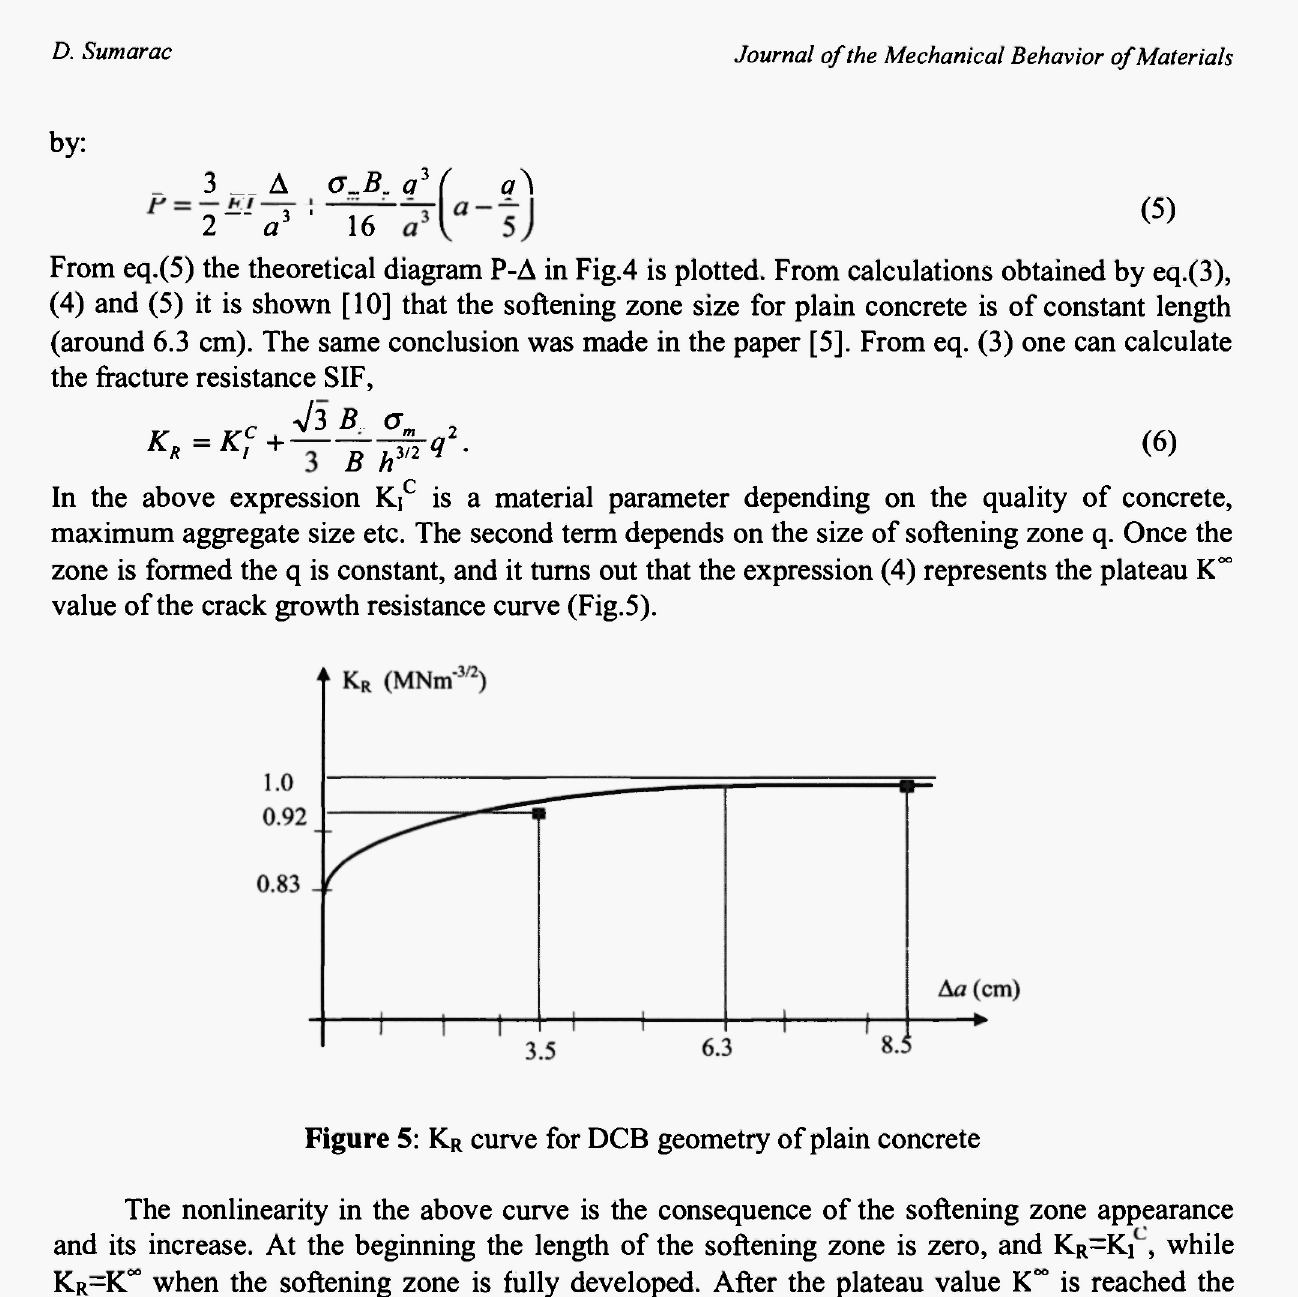
Figure 5: K curve for DCB geometry of plain R